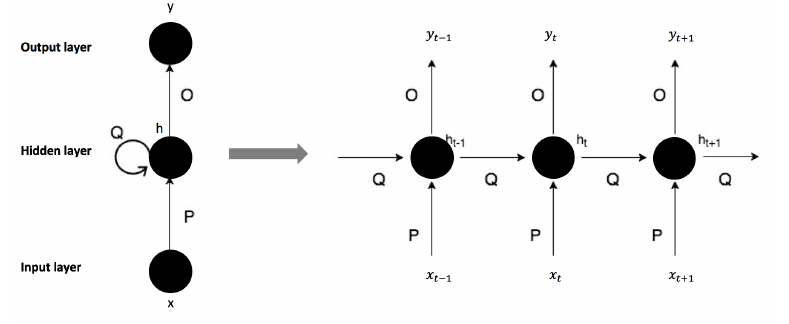
Figure 2. The recurrent structure of